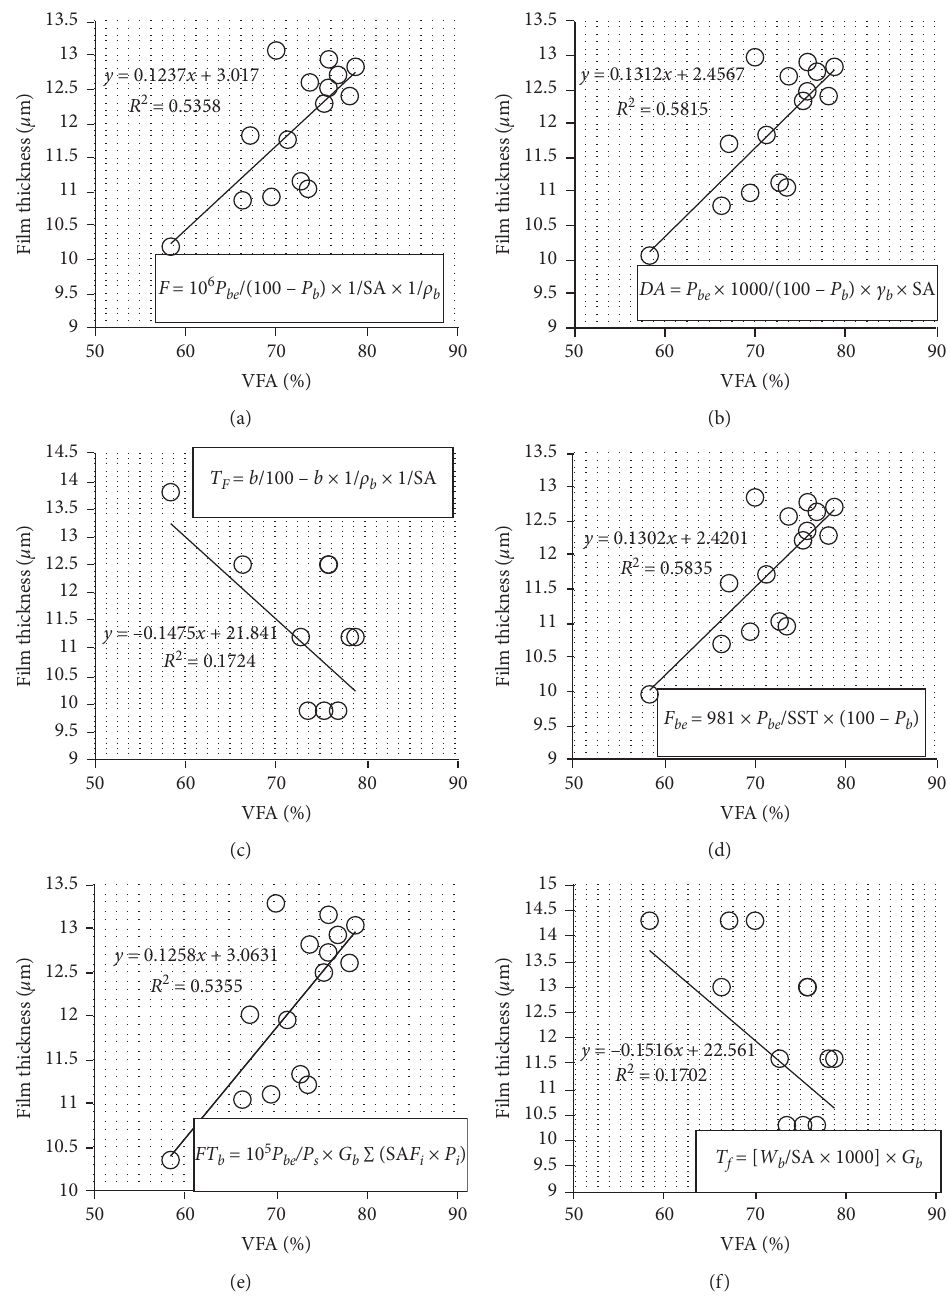
Figure 4: Relation between film thickness and